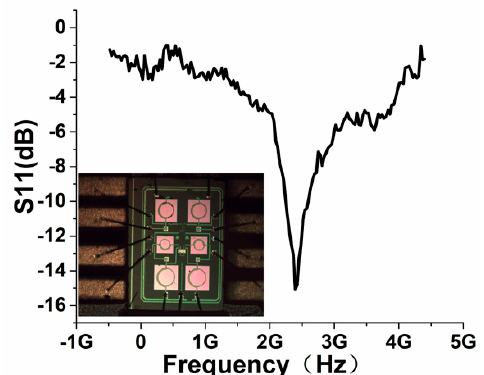
Figure 17. Chip micrograph and the measured result of S11.